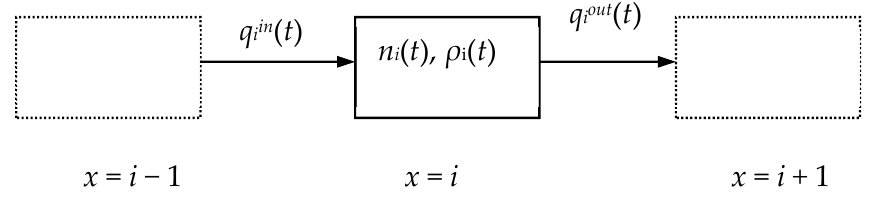
Figure 1. Cell element and its characteristics.